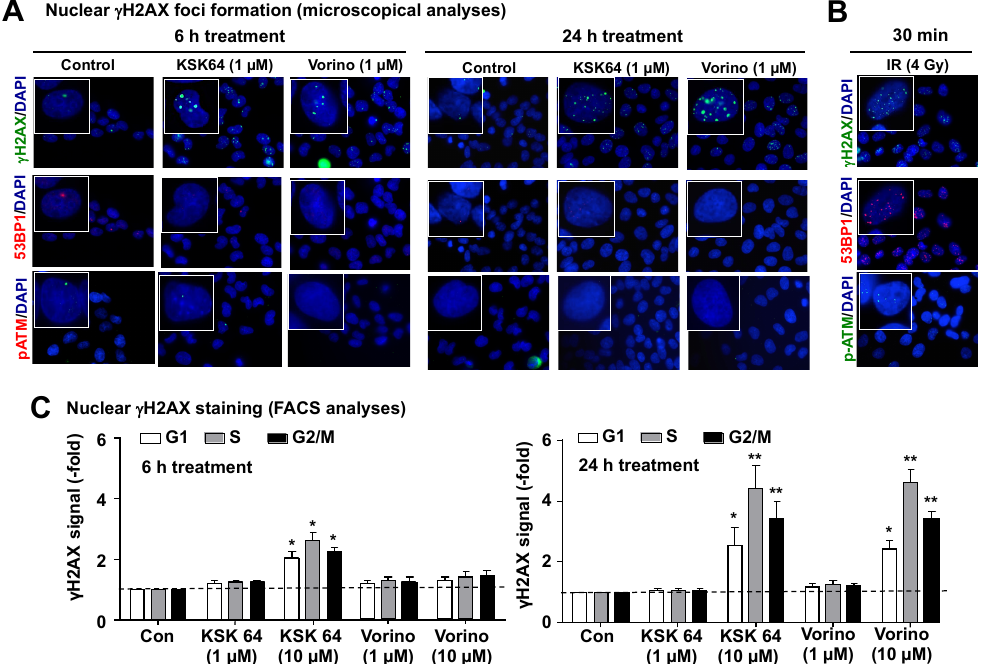
Figure 4. Cell cycle-related formation of DNA damage by hydroxamic acid- and benzamide-type HDACi. ( A ) Six to 24 h after addition of the hydroxamic acid-based HDACi KSK64 and vorinostat, the formation of γH2AX, 53BP1, and pATM foci (Ser1981 phosphorylated ATM) was analyzed in V79 cells. ( B ) For positive control, ionizing radiation (IR) was used. Shown are representative pictures of γH2AX, 53BP1, and pATM stained cells. ( C ) Six to 24 h after the addition of the hydroxamic acid-based HDACi KSK64 or vorinostat, the γH2AX signal intensity was determined in cells present in different phases of the cell cycle (i.e. in G1-, S-, and G2/M-phase) by flow cytometry-based method as described in Methods. Data shown are the mean ± SD from three independent experiments (n = 3); *, p ≤ 0.05; **, p ≤ 0.01 as compared to the untreated control, which was set to 1.0 (Student´s t-test).